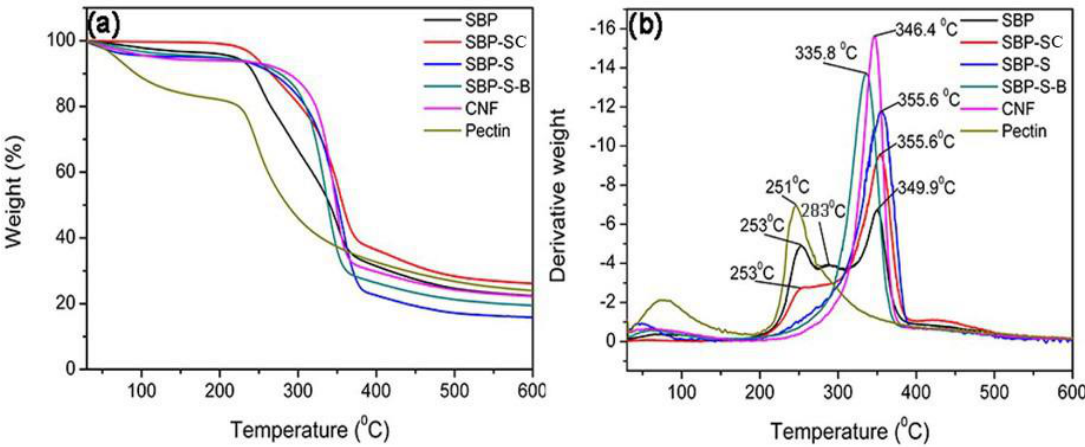
Figure 2. ( a ) Thermal gravimetric (TG) and ( b ) differential thermogravimetric (DTG) curves of SBP, SBP-SC, SBP-S, SBP-S-B, CNFs, and pectin. Table 2. Maximum degradation temperatures and crystallinity indices of samples at different